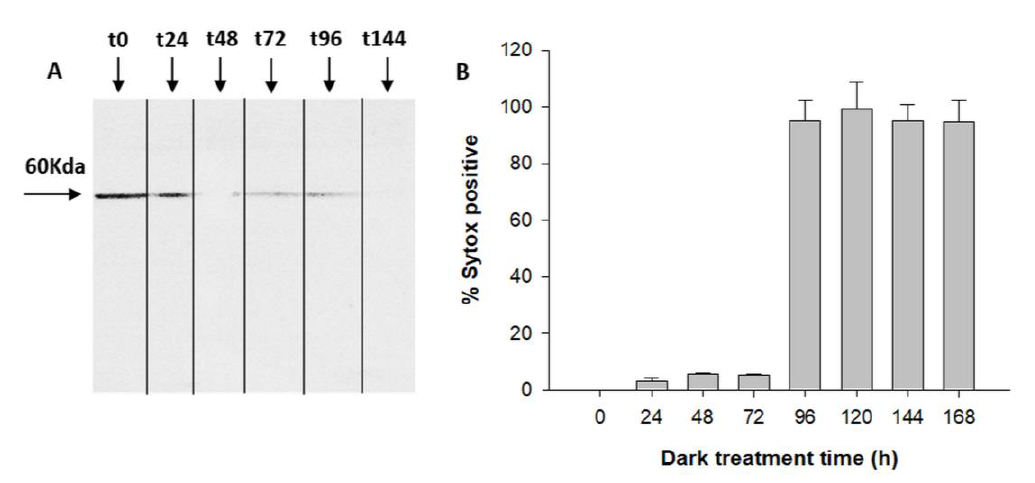
Zymograms and peptide-mass fingerprinting analyses revealed the identities of the Rase activities